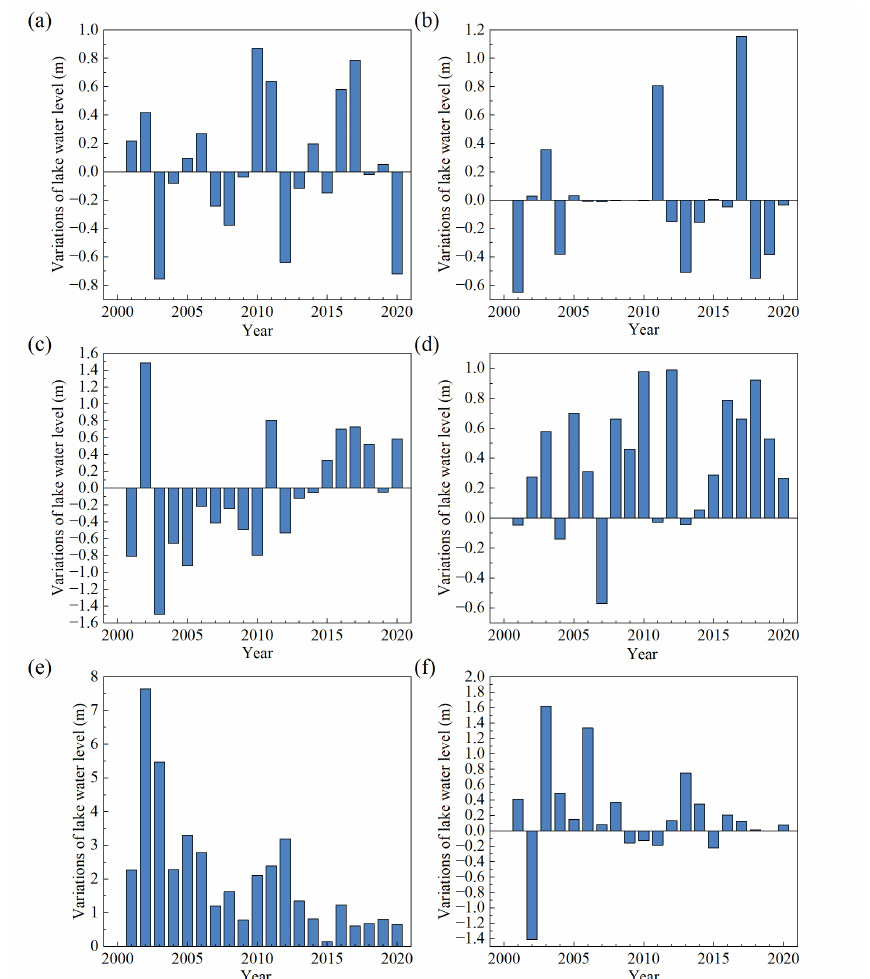
Figure 3. Annual water level changes ( a ) Ulungur Lake; ( b ) Manas Lake; ( c ) Bosten Lake; ( d) Ayakkum Lake; ( e ) Aqqikkol Lake; ( f ) Aksayquin